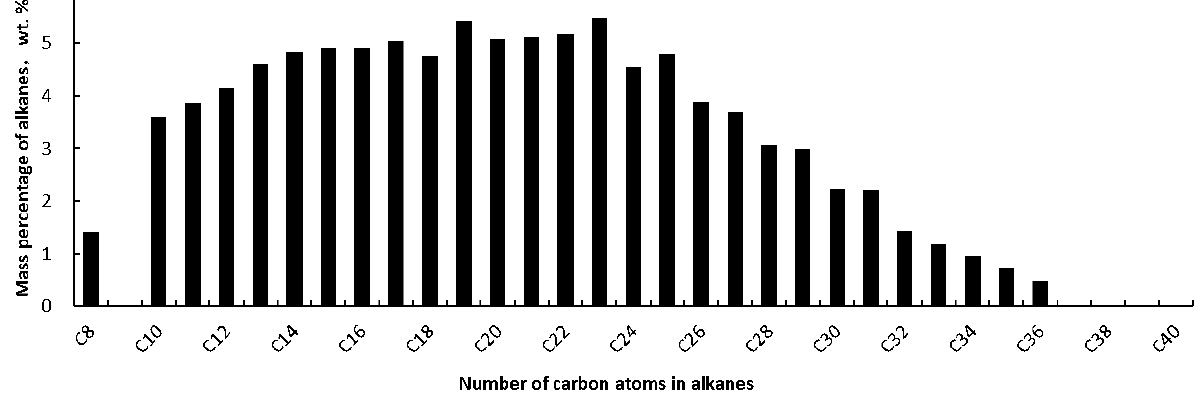
Figure 5. Concentration profile of alkanes with different numbers of carbon atoms in the crude oil